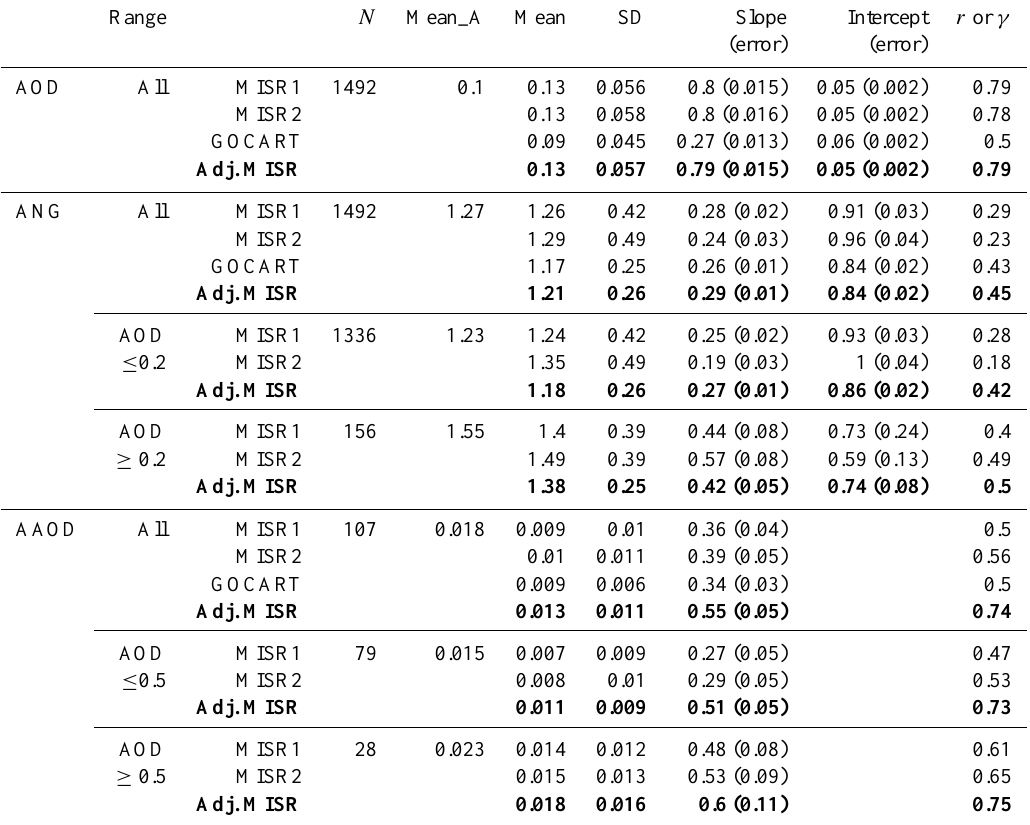
Table 1. Validations of MISR, GOCART, and our work’s aerosol optical properties by AERONET in different AOD conditions. Range N Mean_A Mean SD Slope Intercept r or γ (error) (error) AOD All MISR1 1492 0.1 0.13